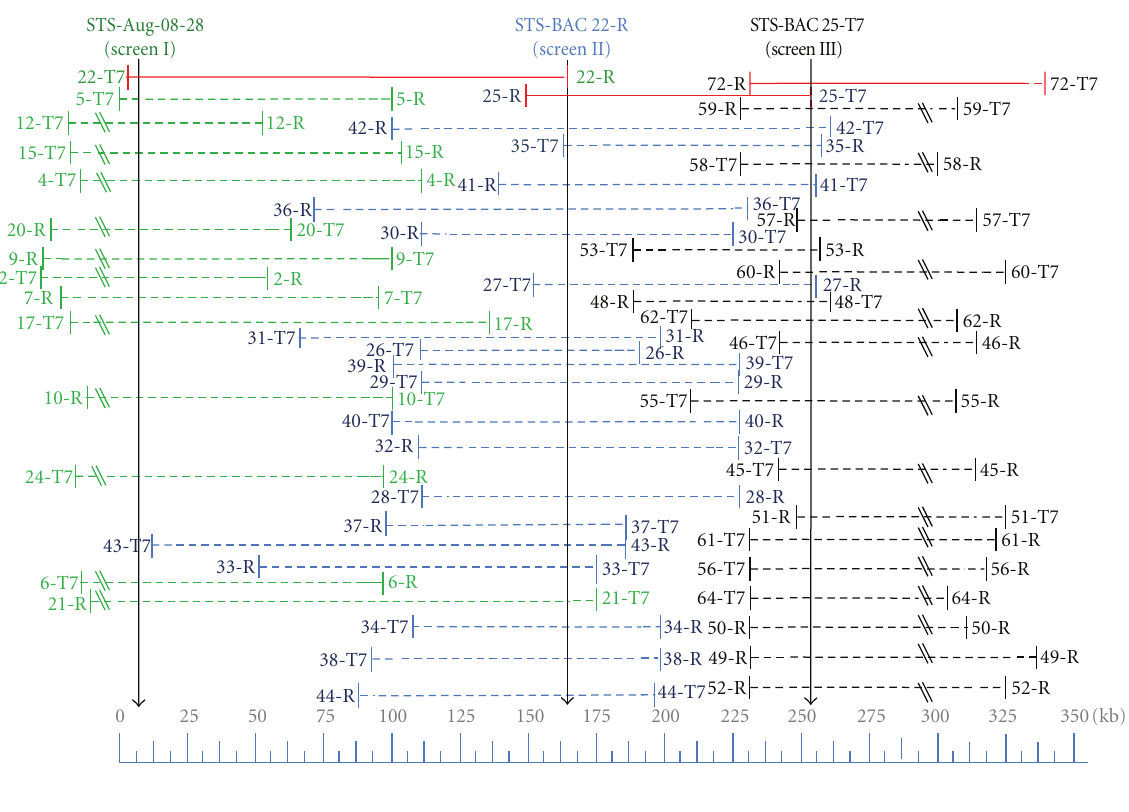
Figure 3: Three rounds of screening the 7DL library by hybridization.